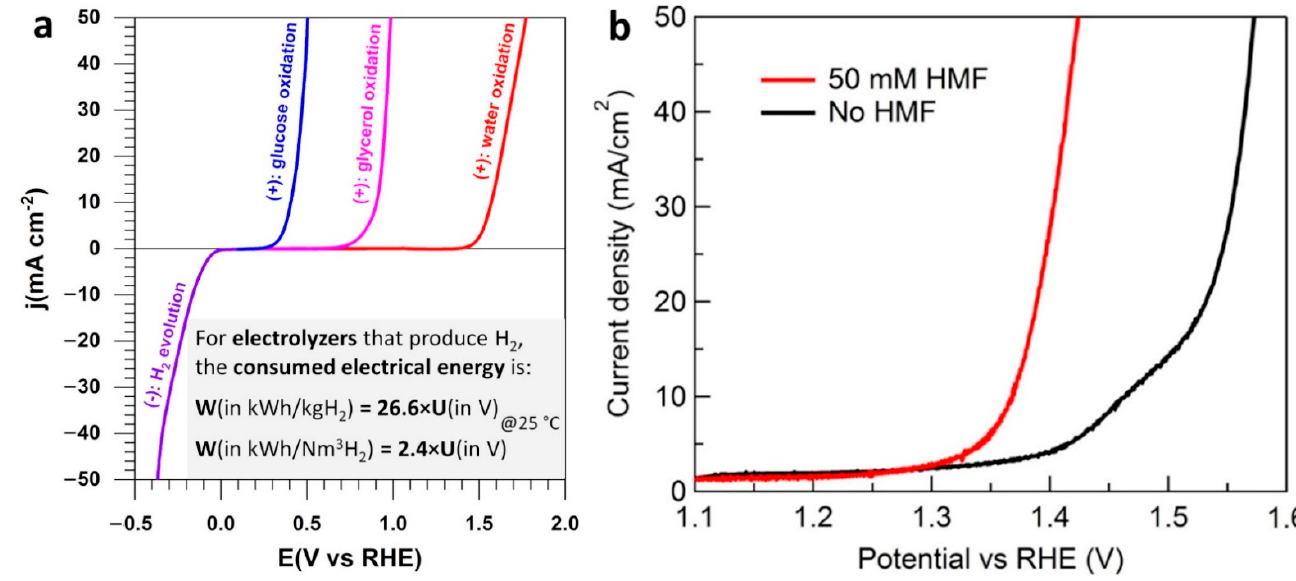
Figure 10. ( a ) Typical half-cell electrolysis polarization curves illustrating the working principle of solid alkaline membrane electrolysis cell [6]. ( b ) LSVs of Co − P/CF (1 M KOH, 2 mV s − 1 ) in the absence (black) and presence of 50 mM HMF (red). ( a ) Reprinted and adapted with permission from ref. [6], Copyright 2020, The Royal Society of Chemistry 2020. ( b ) Reprinted and adapted with permission from ref. [12], Copyright 2016, American Chemical Society.